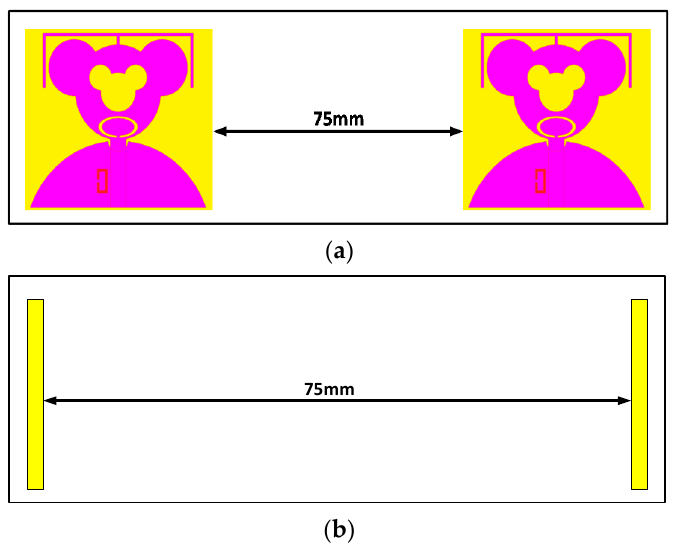
Figure 15. Two different orientations of the presented radiator for time-domain analysis: ( a ) side-by-side and ( b ) face-to-face orientations.